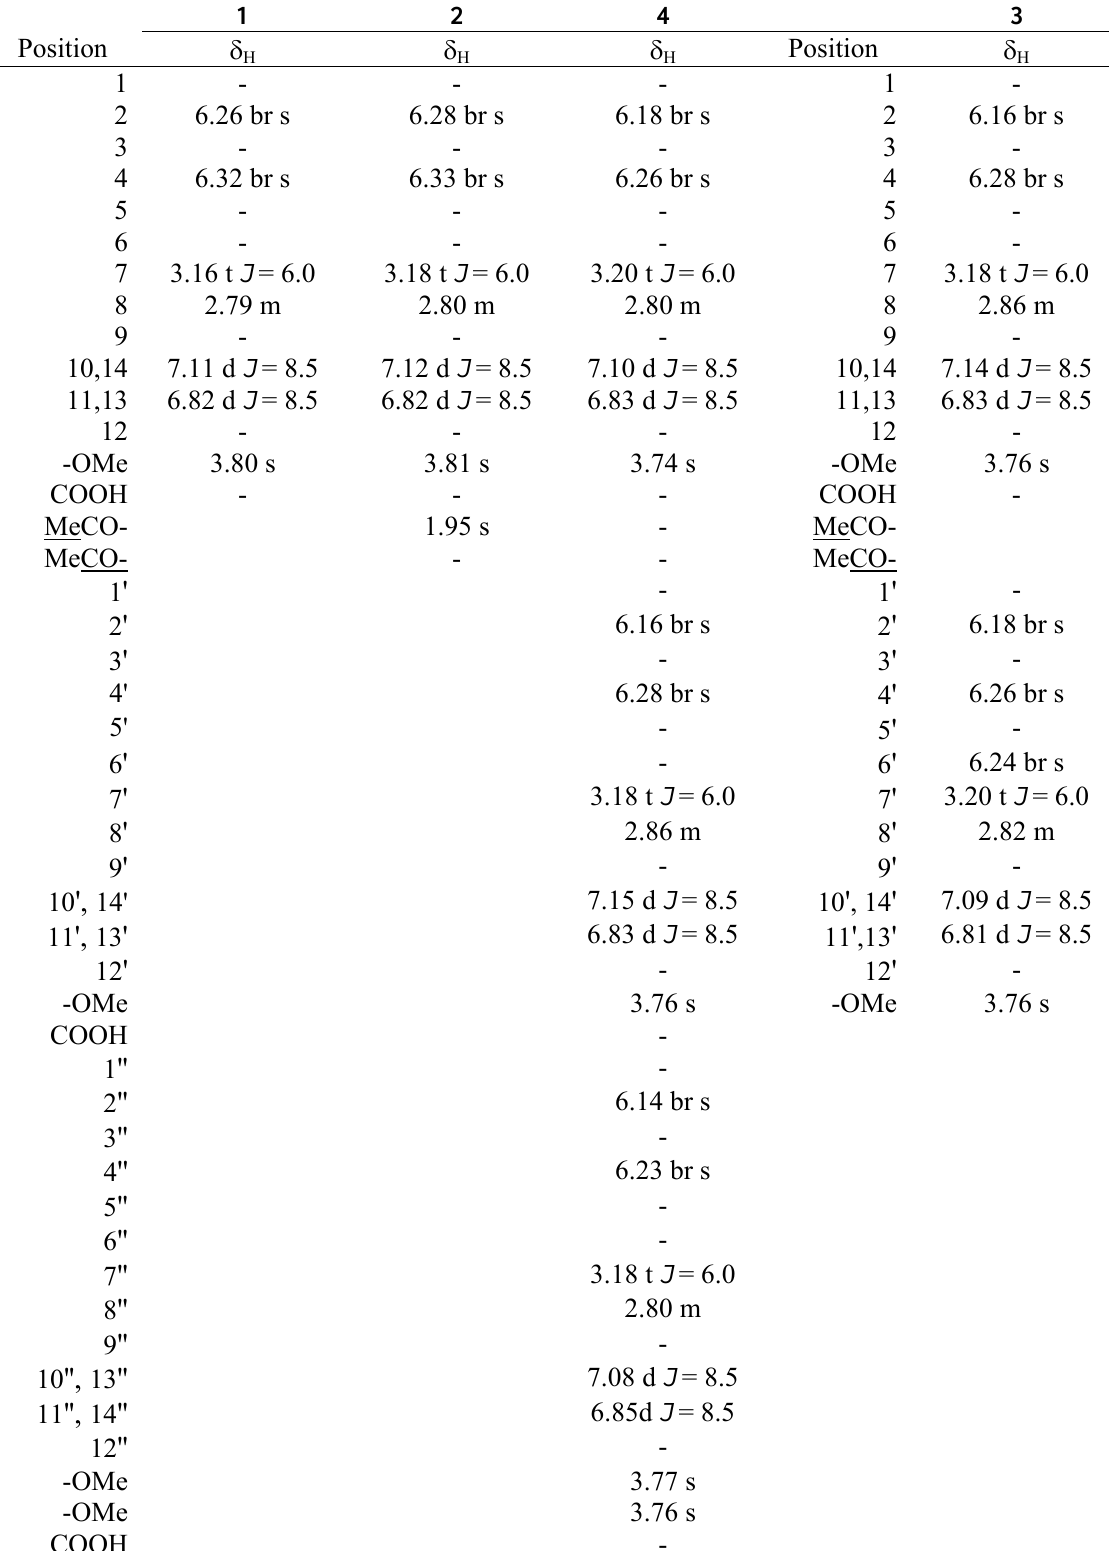
OD, 600 MHz in methanol- d 3